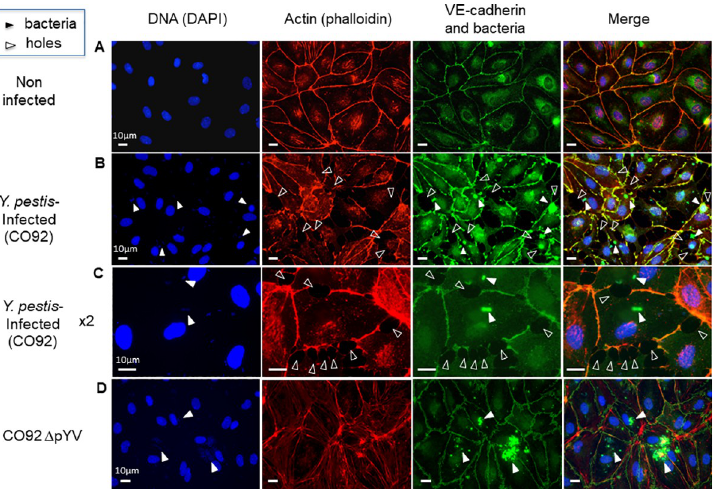
Fig 4. Disruption of a monolayer of vascular endothelial cells by Y . pestis . HDMEC monolayers were either uninfected ( A , control), infected for 2.5h with the CO92 strain of Y . pestis at a MOI of 100 ( B and C ) or with a CO92 strain cured of the pYV/pCD1 plasmid ( D ); Panel C is a 2x magnification for better visualization. bars = 10 μ m. The cells were fixed and stained to visualize their DNA (DAPI, blue), actin (phalloidin, red), and tight junctions (anti-VE- cadherin antibody, green). Bacterial cells on the monolayers were stained with an antibody directed against the F1 pseudocapsule (green) and their DNA was labeled with DAPI. Holes at the cell junctions were observed in the monolayers infected with Y . pestis (white empty arrowheads point at some holes in panels B and C). Contrast on the green panel B was enhanced to improve visualization of the holes. Bacterial DNA (DAPI) and Y . pestis were visible on the HDMEC monolayer at high magnification (white plain